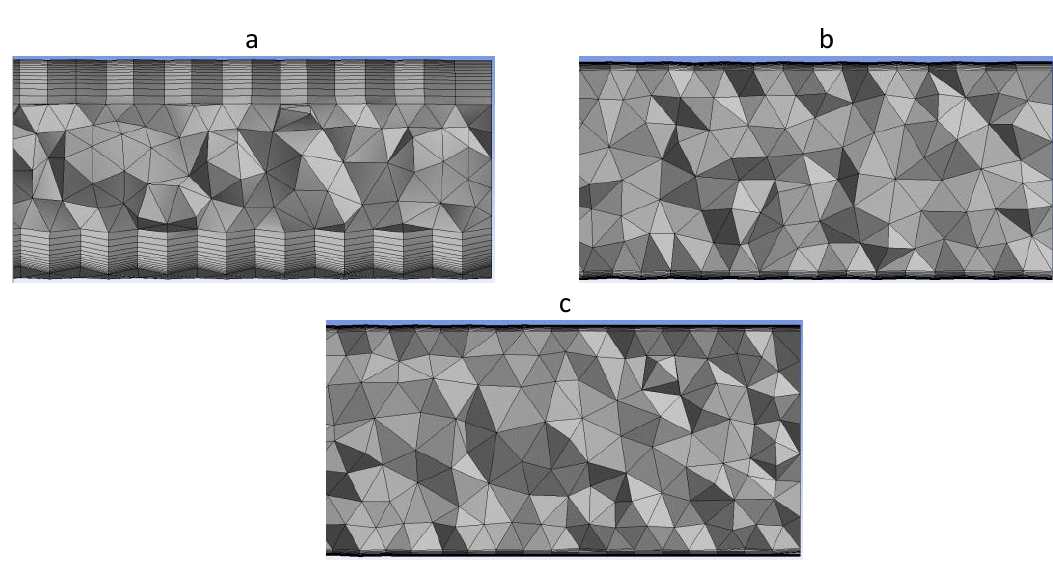
Figure 2. Mesh section for the turbulent numerical simulation using water of: Grid 1 ( a ); Grid 2 ( b ); and Grid 3 ( c